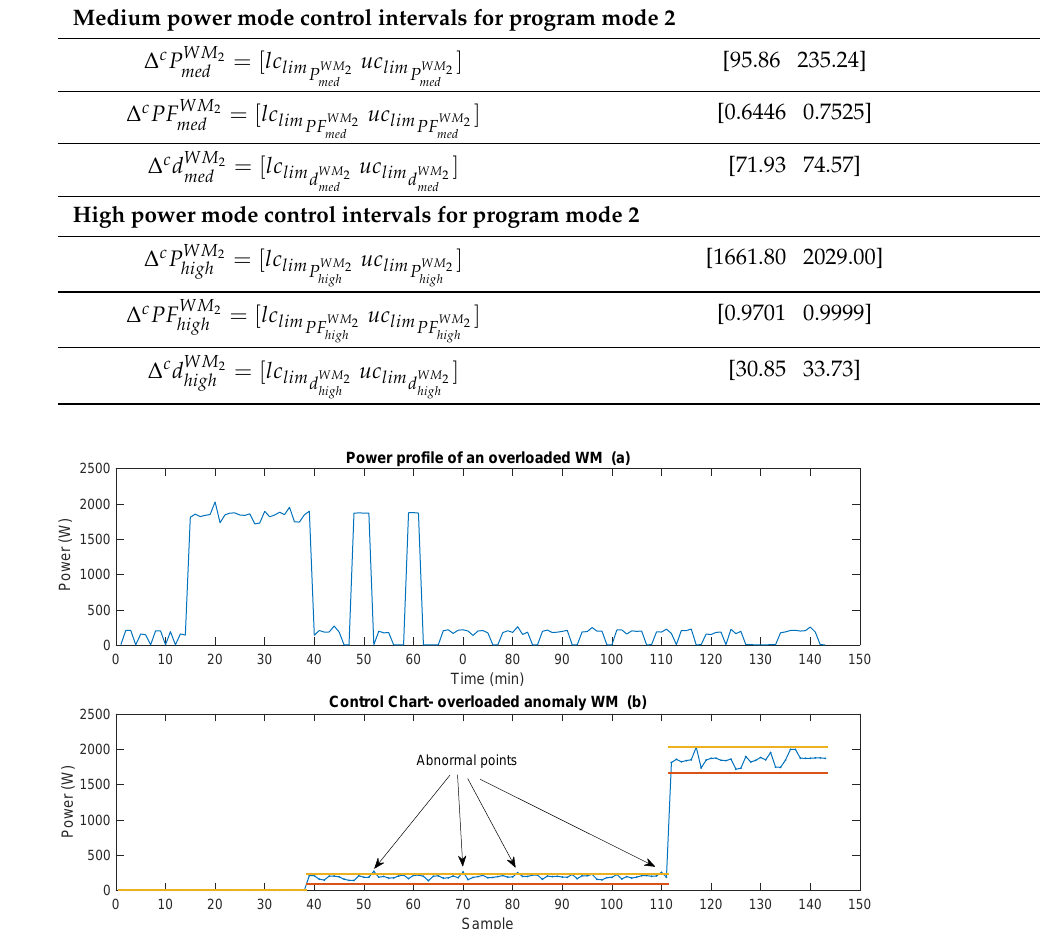
Figure 12. Power profiles and CC of an overloaded